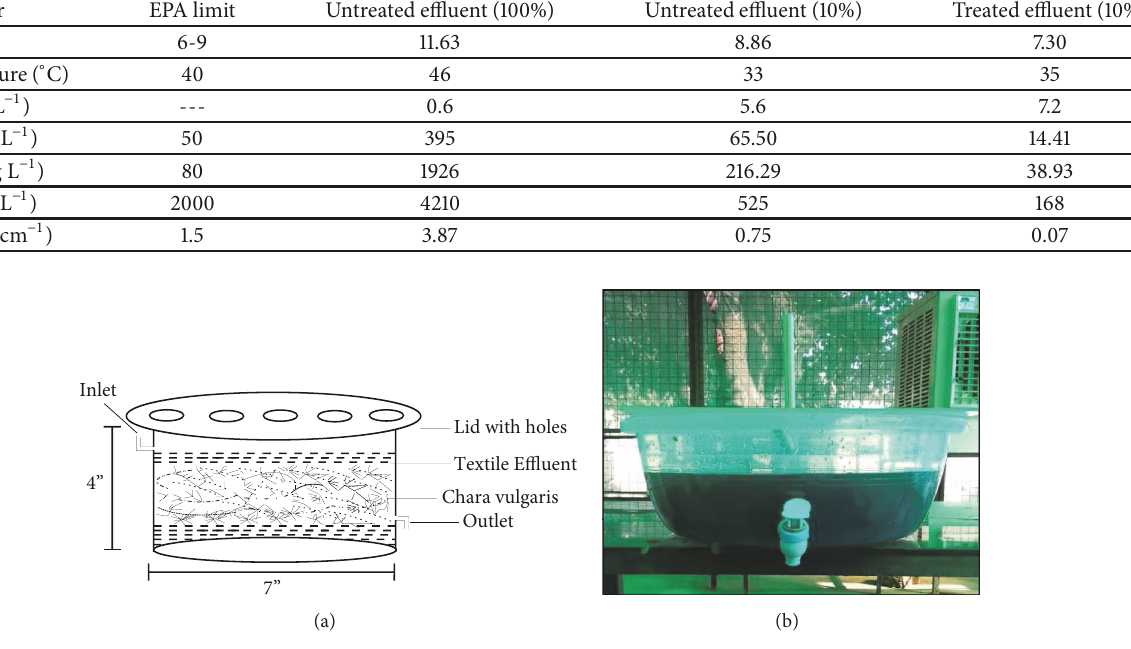
Figure 1: (a) Cross section view; (b) original image of